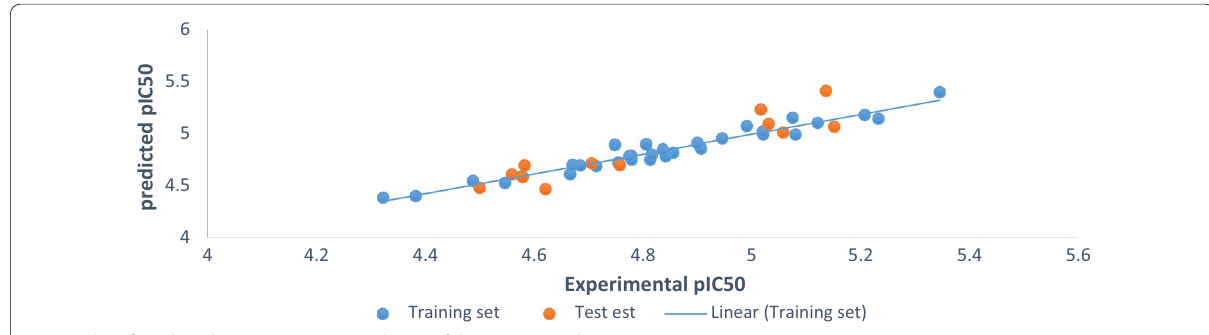
Fig. 2 Plot of predicted against experimental Pic 50 of the training and test set